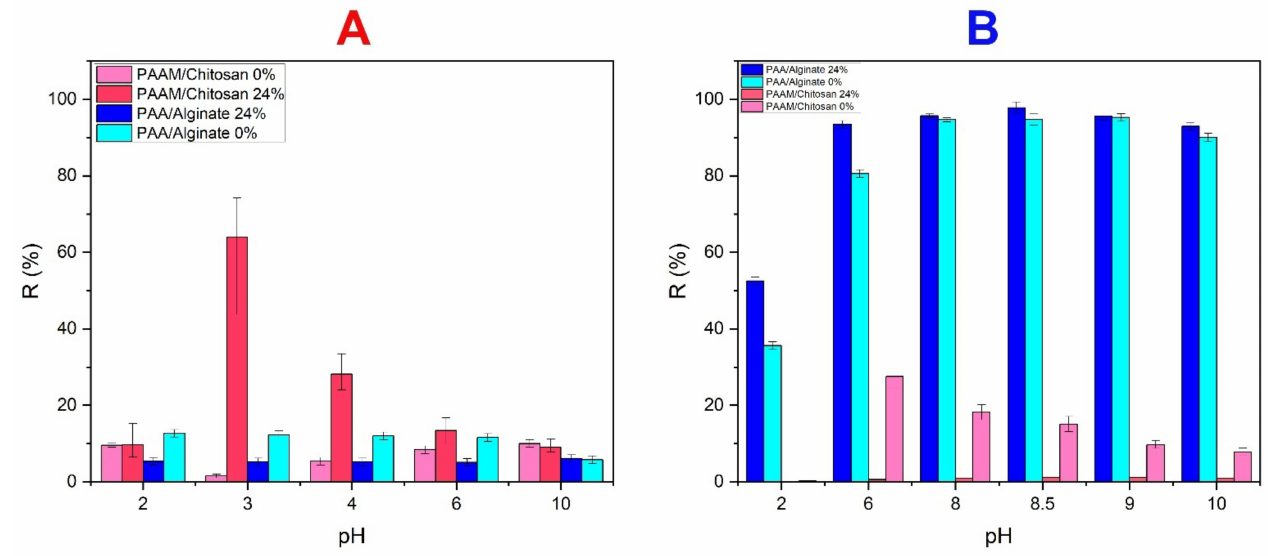
Figure 9. Effect of pH on the adsorption capacity. ( A ) Xerogel PAAM/chitosan (0.05 g) adsorbing MO (10 mg/L). ( B ) Xerogel PAA/Alginate (0.05 g) adsorbing MB (10